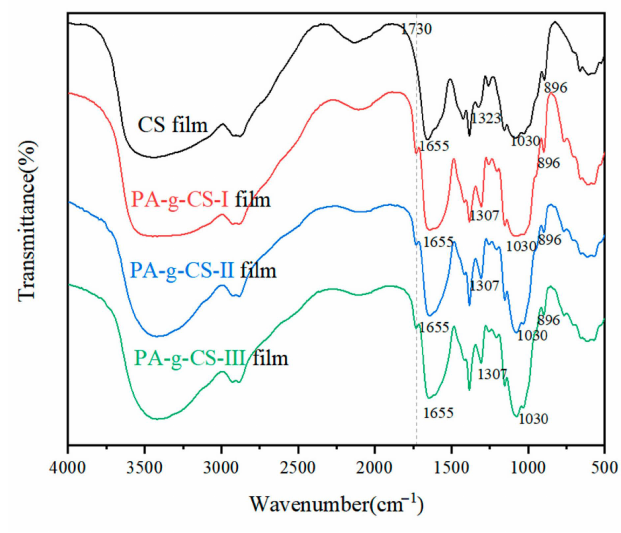
Figure 1. FT-IR spectra of CS and PA-g-CS films.